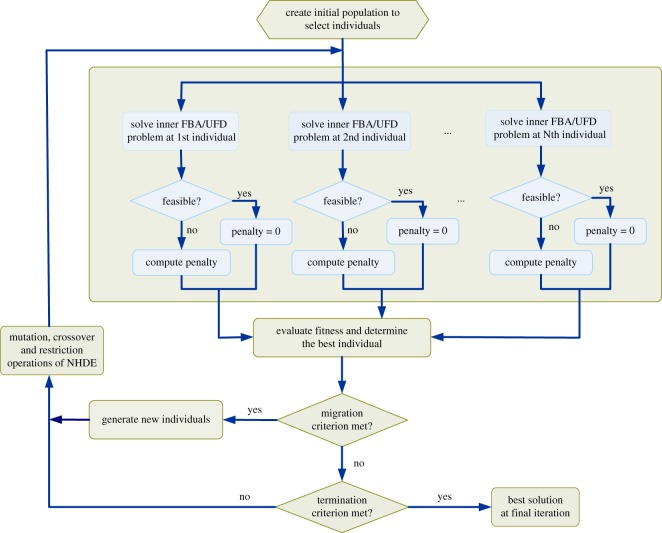
Flowchart of the NHDE algorithm. Hybrid differential evolution was applied to determine the outer decision variables and objective function. The inner optimization problem is a parallel computation in which each FBA problem was solved through linear programming to evaluate fitness in the NHDE algorithm.